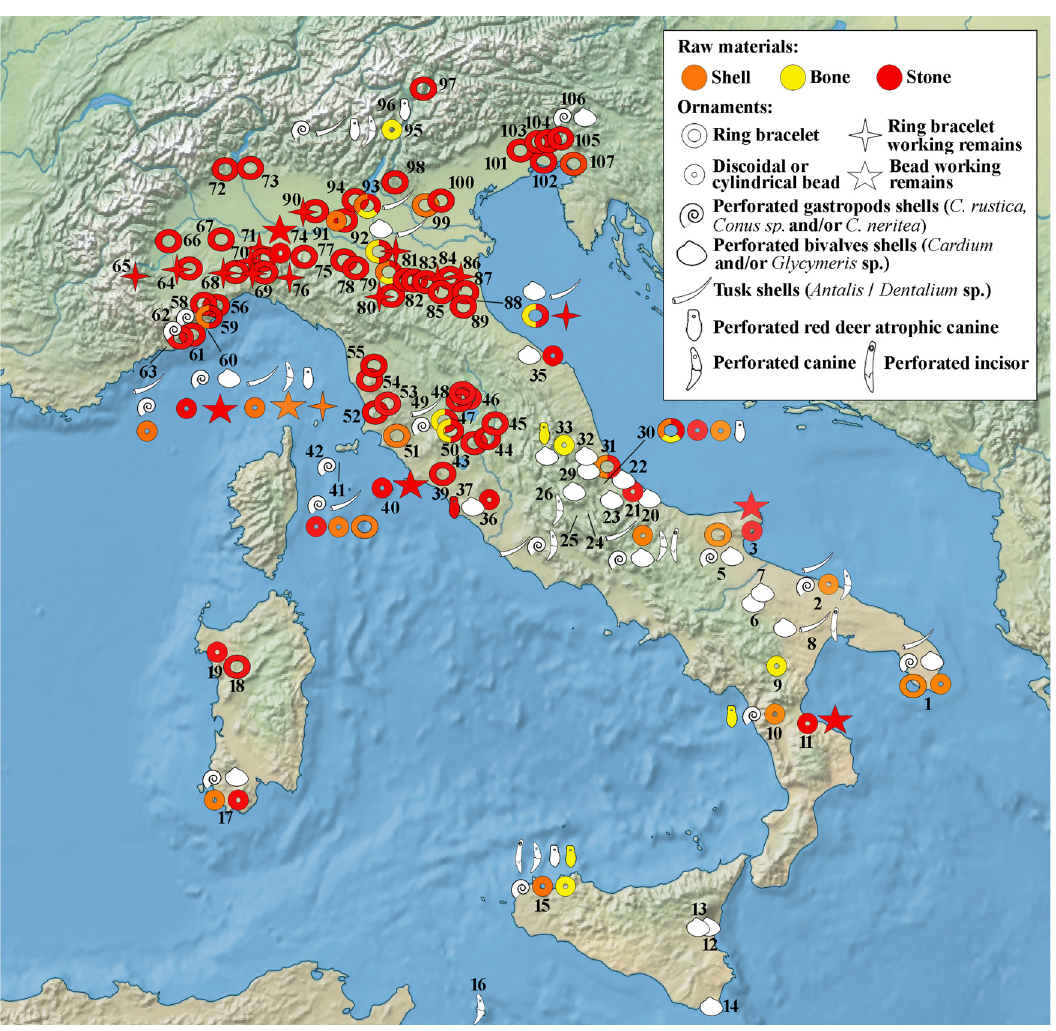
Figure 3: Distribution map of the main types of Early Neolithic ornaments in Italy ( for details, see Figure 2 and Supplementary Materials fi le )